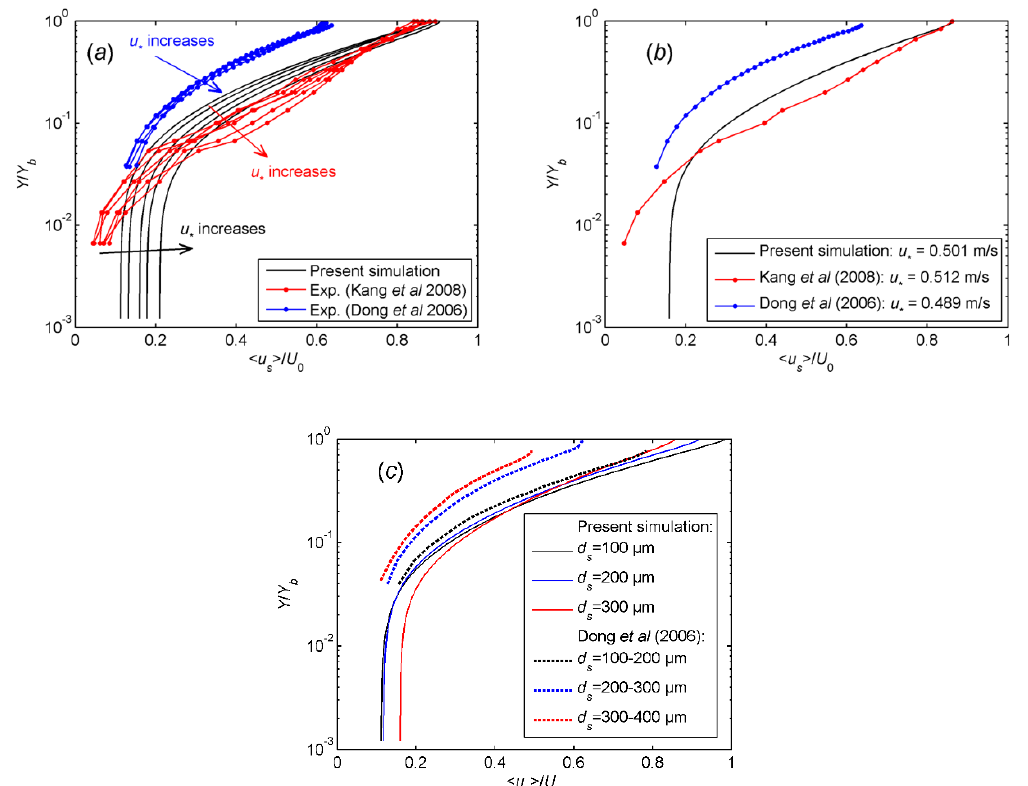
Figure 3. Variations with height of the average streamwise sand velocity. ( a ) Profiles vary with friction velocity, where the values for u ∗ and d s can be found in Table 1. ( b ) A specific comparison selected from panel ( a ), in which d s ≈ 250 µ m. ( c ) The profile varies with particle diameter. u ∗ equals 0.395 m / s and 0.407 m / s for the present simulation and Dong, respectively